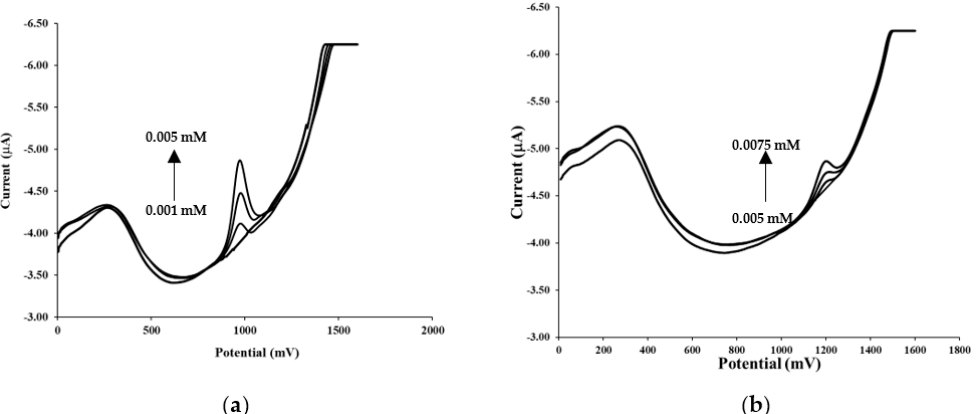
Figure 5. AdSDPV of sensor in various concentrations of ( a ) EZE and ( b ) ROS using the AdSDPV technique in 0.1 M H 2 SO 4 (stripping conditions: accumulation potential of 0.0 V and accumulation time of 15 s). Table 1. Statistical assessment of the calibration data for determination of ROS and EZE by the AdSDPV method in 0.1 M H 2 SO 4 (stripping conditions: accumulation potential of 0.0 V and accumulation time of 15 s).